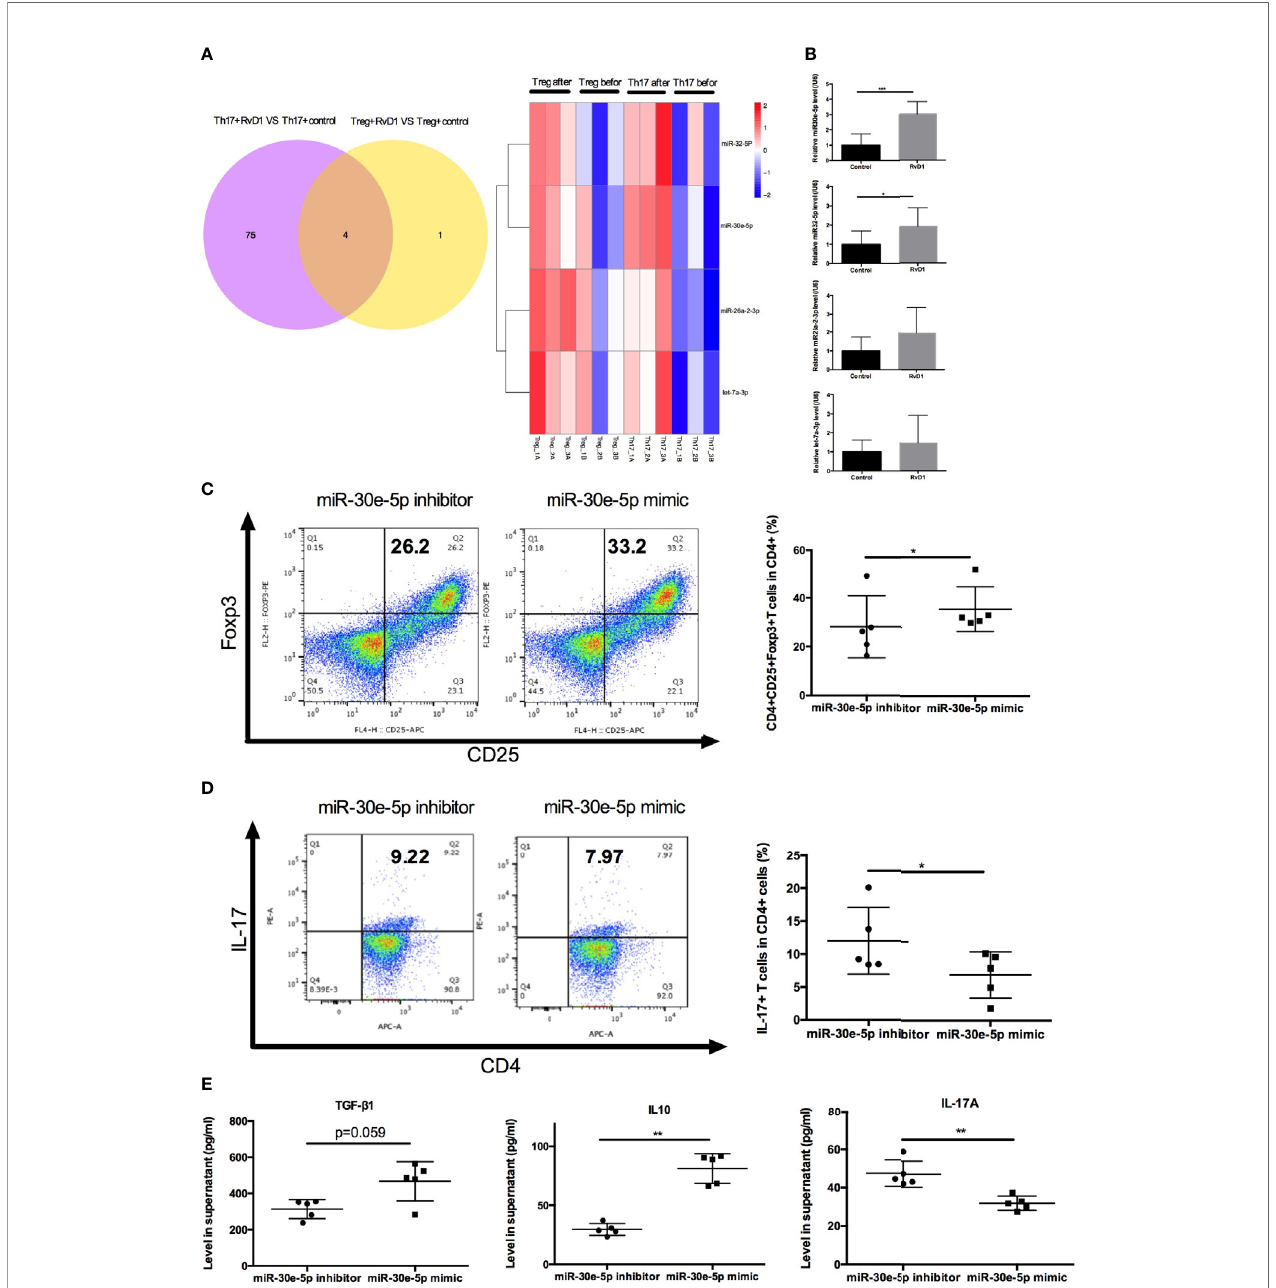
FIGURE 5 | Effect of miR-30e-5p on the differentiation of naive CD4+ T cells from patients with SLE. (A) Venn diagram and heatmap analysis of miRNA expression pro fi les in Treg and Th17 differentiation from naive CD4+ T cells before and after RvD1 treatment. (B) The expression of miR-30e-5p, miR-32-5p, miR-26a-2-3p and let-7a-3p were veri fi ed by qPCR in independent SLE patients (n=10). (C, D) Representative fl ow cytometric plots indicated the percentage of Treg and Th17 cells polarized from naive CD4+ T cells transfected with miR-30e-5p mimic or inhibitor. (E) The level of TGF- b 1, IL-10, and IL-17 in supernatant were detected by ELISA. All data are mean ± SEM. n=5 per group. *** p <